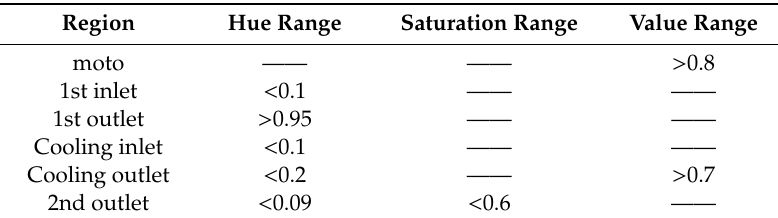
Table 2. The threshold for segmentation of each region.